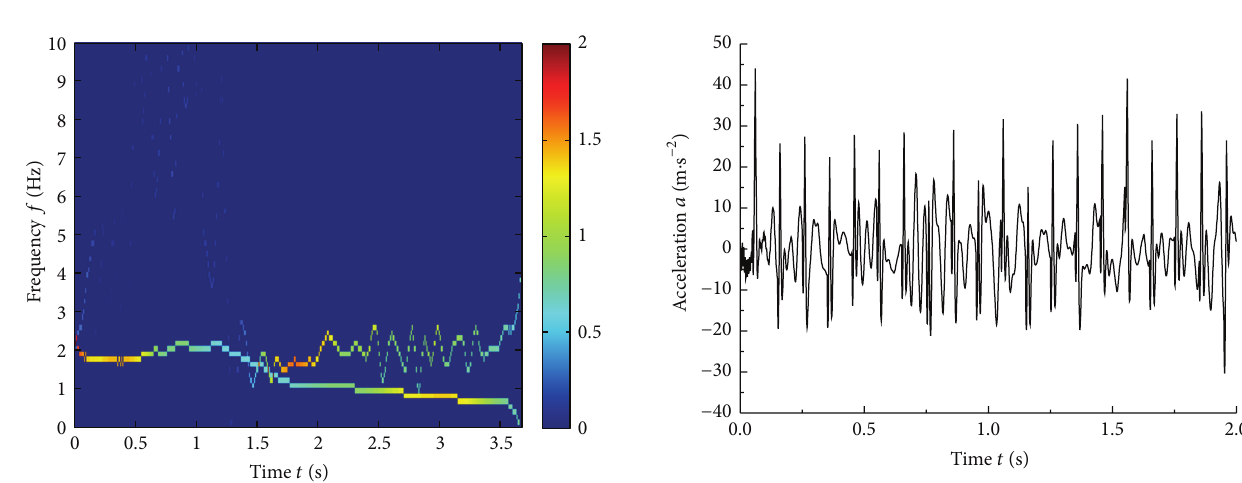
Figure 9: Hilbert spectrum of the simulated signal 𝑧(𝑡) after EEMD analysis.